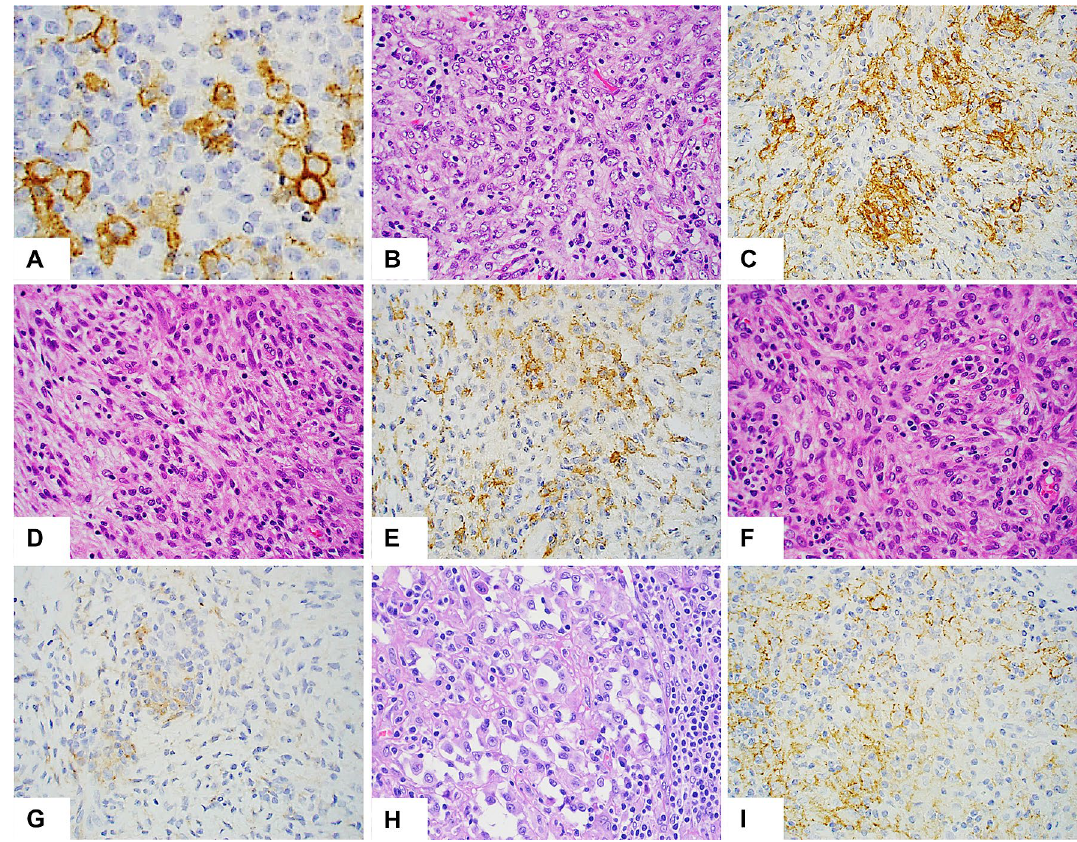
Figure 1. Representative examples of H&E and PD-L1 staining. ( A ) High magnification shows positive membranous staining predominantly on tumor cells (large cells with abundant cytoplasm) along with rare positive immune cells. H&E and PD-L1 staining in case #27 ( B , C , 3 + expression), #11 ( D , E , 2 + expression) and #7 ( F , G , 1 + expression), respectively. ( H ) H&E from case #25 shows that the tumor is composed of clusters of loosely cohesive epithelioid cells exhibiting prominent pericellular clearing surrounded by abundant lymphoplasmacytic infiltrates. ( I ) The tumor cells from case #25 show diffuse PD-L1 expression (3 +) along with 1 + immune cell staining. Original magnification: ×1000 for ( A ); ×400 for ( B – I